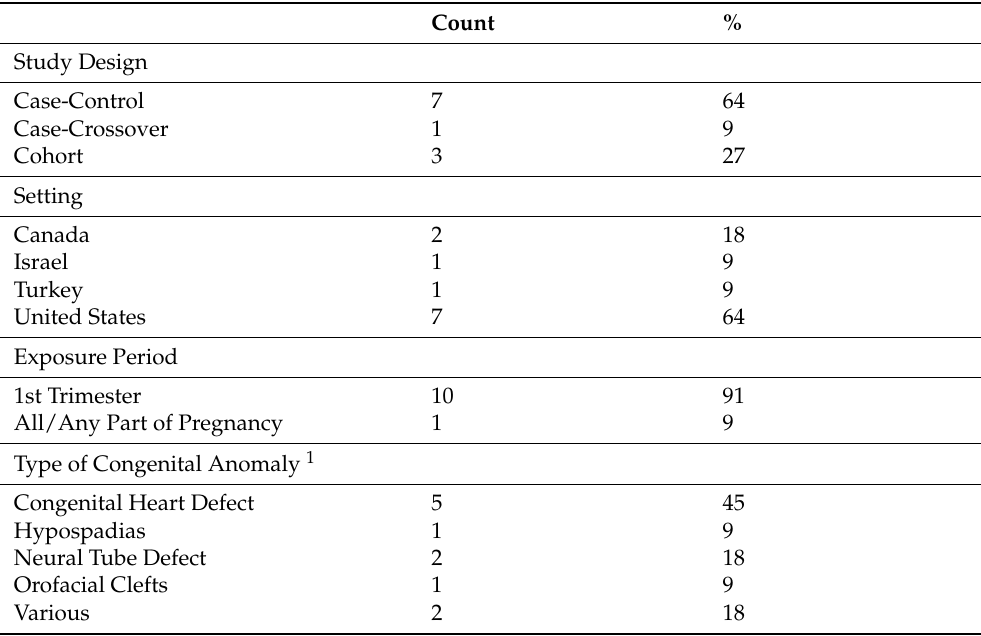
Table 5. Congenital Anomaly Study Characteristics n =